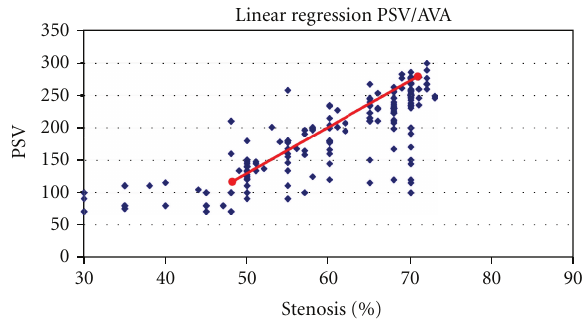
Figure 6: Scatter plots of absolute PSV measurements and percent- age of carotid stenosis using MDCTA-AVA software measurements. The linear regression analysis showed a significant correlation between MDCTA-AVA percentage stenosis and PSV ( r = 0 .